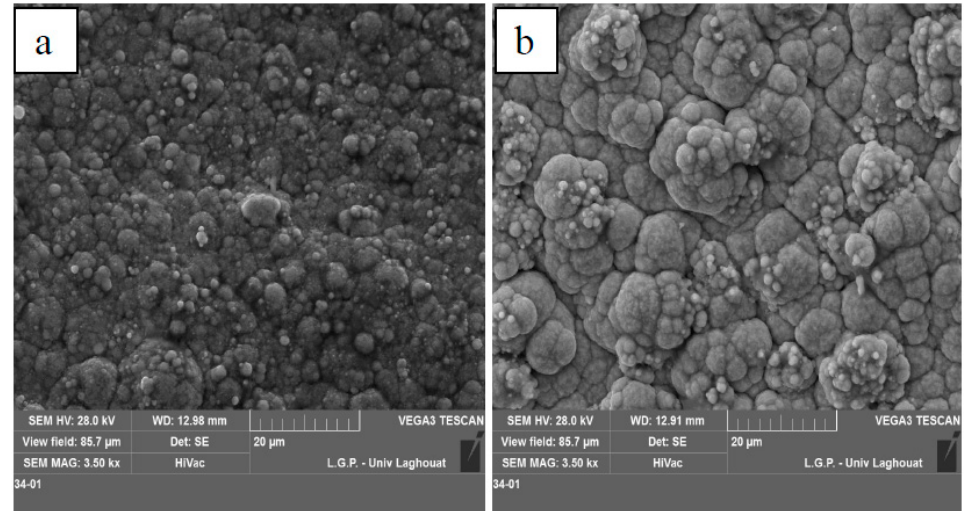
Figure 6. Surface SEM images of the electrodeposited nickel film with the incorporation of ( a ) 5 g/L of TiO 2 , ( b ) 10 g/L of TiO 2.